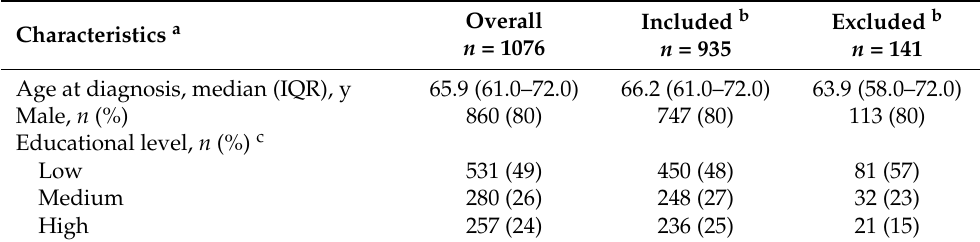
Table 2. Baseline characteristics of 1076 Dutch patients with non-muscle invasive bladder cancer who were included or excluded in analyses of the WCRF/AICR